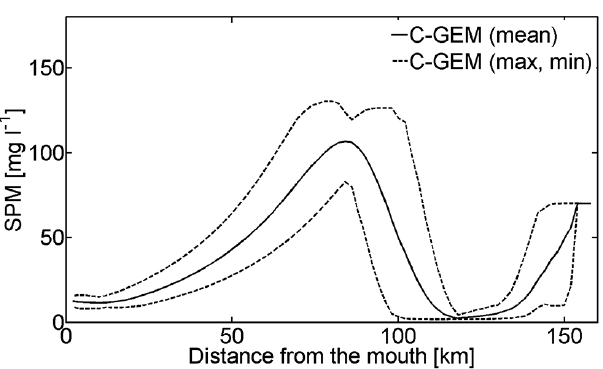
Figure 9. Mean, maximum and minimum longitudinal distribu- tion of SPM concentrations for a constant river discharge Q = 39m 3 s − 1 . Parameters and conditions are listed in Tables 2–4.